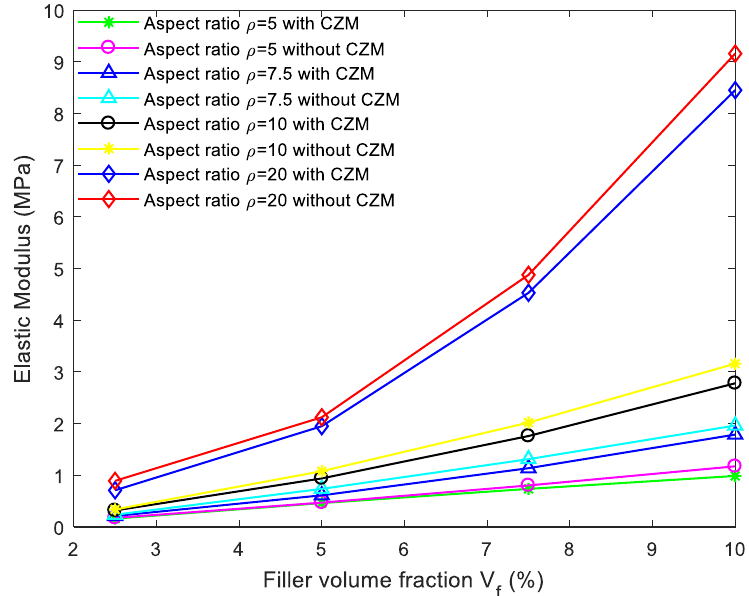
Figure 9. Variations of the effective elastic modulus E e with the clay nanoparticle volume fraction V f at the aspect ratio of ρ = 5, 7.5, 10 , and 20,